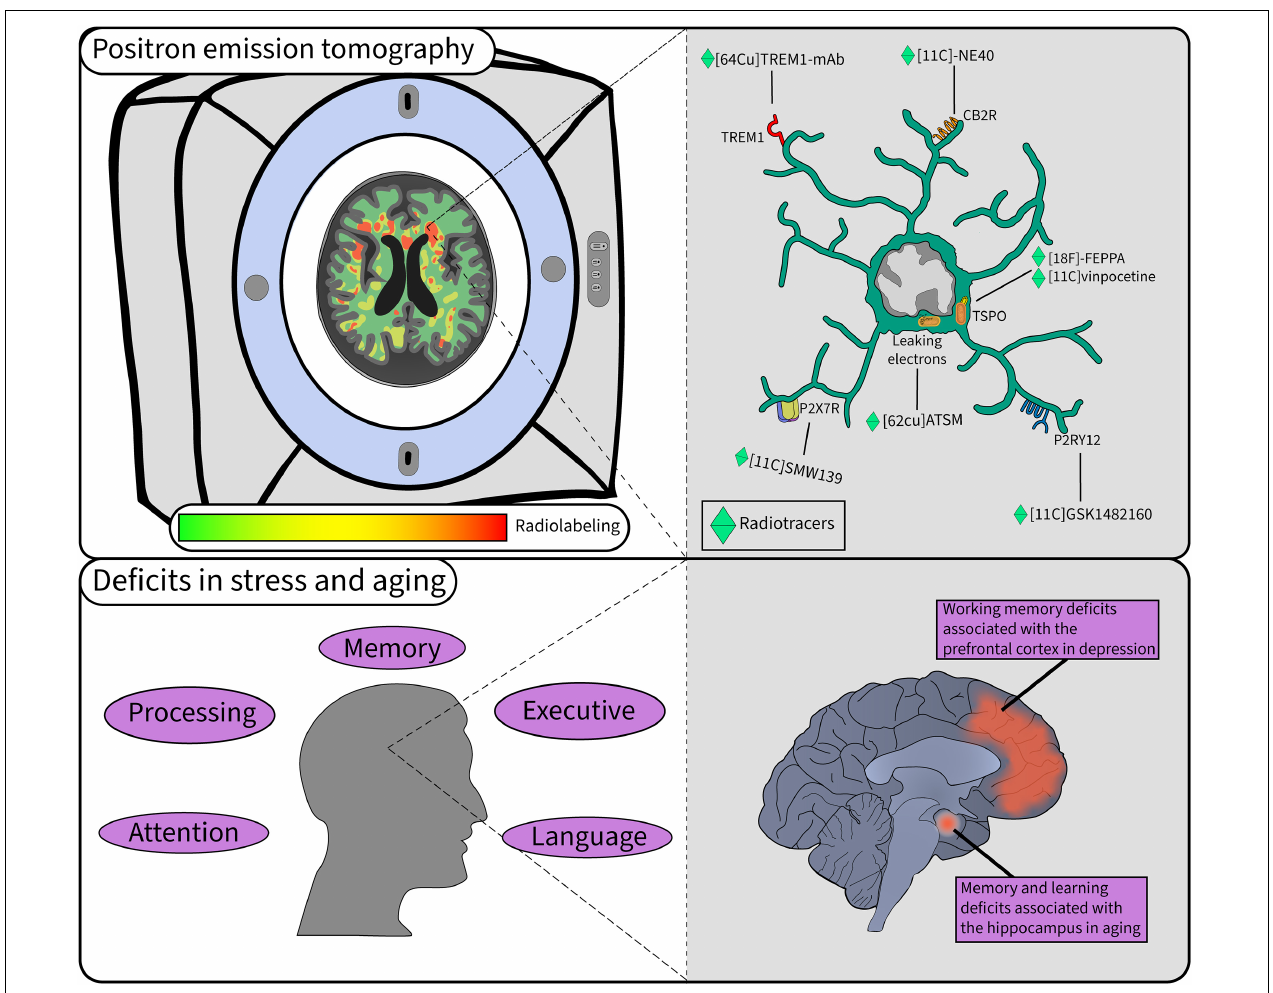
FIGURE 2 | Microglial study using PET in stress and aging. PET is a widely used technique when investigating microglial activity in pathology. In the top left, microglial labeling of radiotracers is quantified to provide insight into their function in the human brain in a non-invasive manner. In the top right a myriad of tracers provide different information on the function of microglia in the brain. The bottom left panel highlights some of the cognitive deficits observed in aging that can be accelerated with chronic stress. The bottom right panel illustrates the key regions and deficits associated with stress and